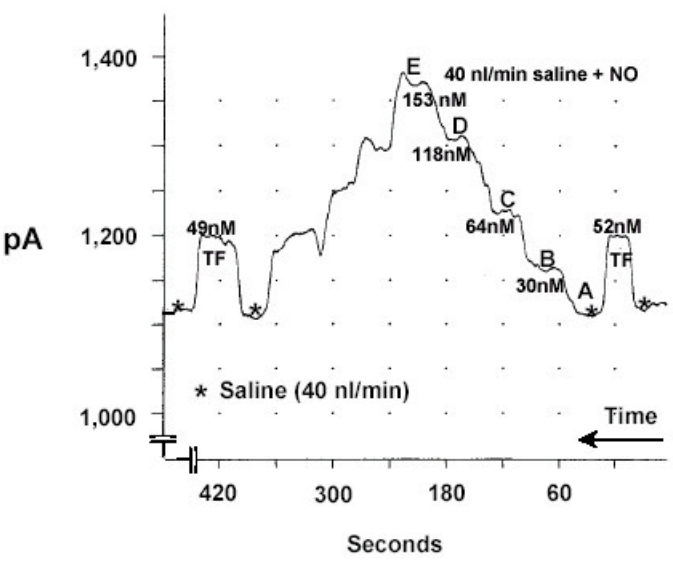
Figure 2 . Intratubular recording of [NO] with perfusion of saline and/or saline equilibrated with NO. The record should be read from right to left. First, a tubule is punctured, the electrode inserted, and [NO] is measured in tubular fluid (TF). Next, an intratubular “zero” is taken (A) after perfusion at 40 nl/min of NO free saline. Then, stepwise increments of the saline/NO solution is perfused with corresponding reduction of the saline perfusate to maintain an approximately constant 40 nl/min flow rate. B, C, D, E, denote 10, 20, 30, 40 nl/min of the saline/NO